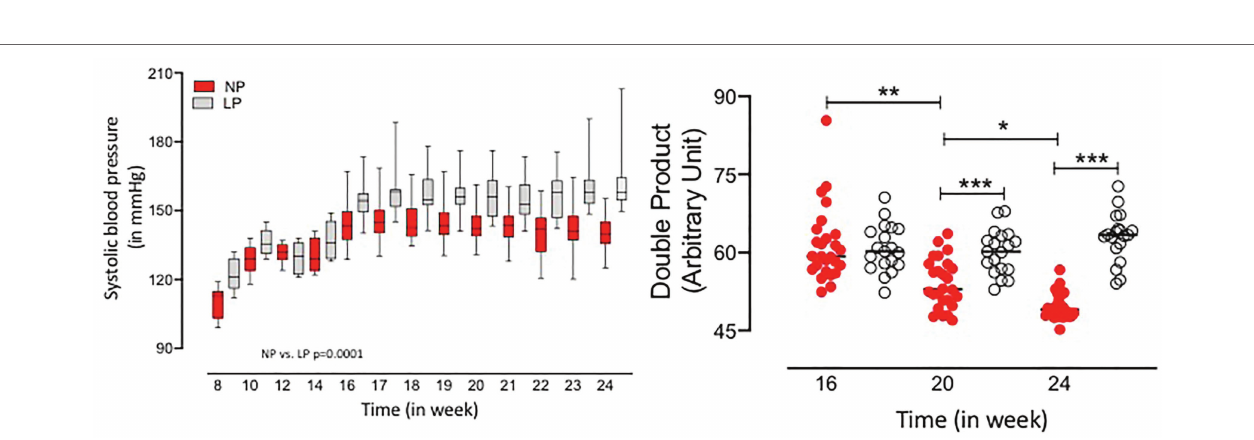
FIGURE 3 | Systolic blood pressure (SBP; in mmHg) and double product (DP) index (in arbitrary unit) from 8 to 24 weeks of age in LP ( n = 12–20) progeny compared to age-matched NP offspring ( n = 18–20). Data are presented as boxes and whiskers (minimum and maximum values); Welch’s ANOVA test was used for data analysis. The level of significance was set at * p = 0.0256; ** p = 0.0117; *** p = 0.001.